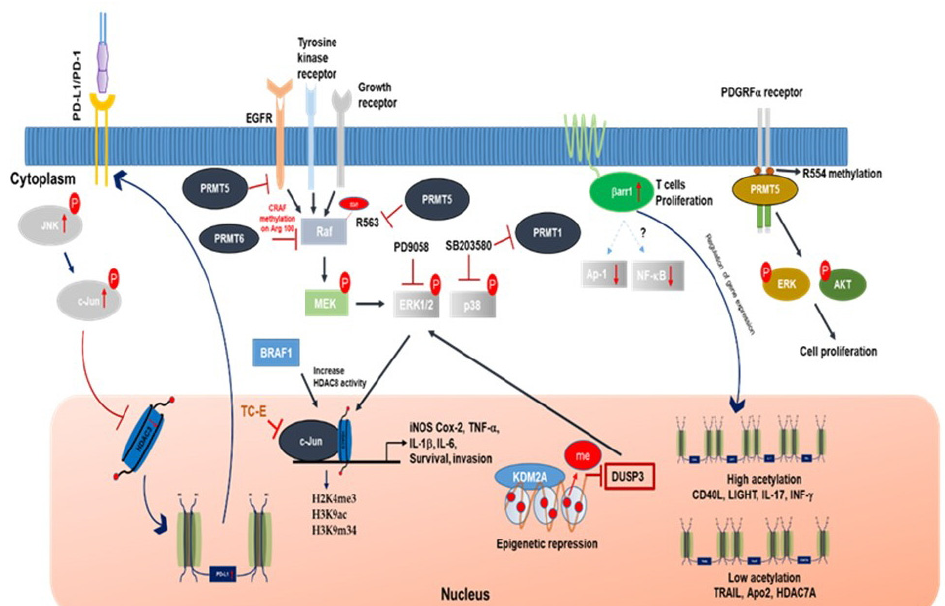
Figure 3. Epigenetic regulation of AP-1 subunits through histone methylation in T cells. In drug-resistant cancer cells, increased JNK phosphorylates c-Jun and translocates it into the nucleus, which inhibits HDAC3 expression and induces the H3 acetylation of the PD-L1 promoter, which increases PD-L1 expression. In addition, β arr1 increased T cell proliferation, downregulated NF- κ B and AP-1 signaling and promoted the acetylation of histone H4 in the CD40L, LIGHT, IL-17, and INF- γ promoter regions while downregulating the histone acetylation of the TRAIL, Apo2, and HDAC7A promoter regions.